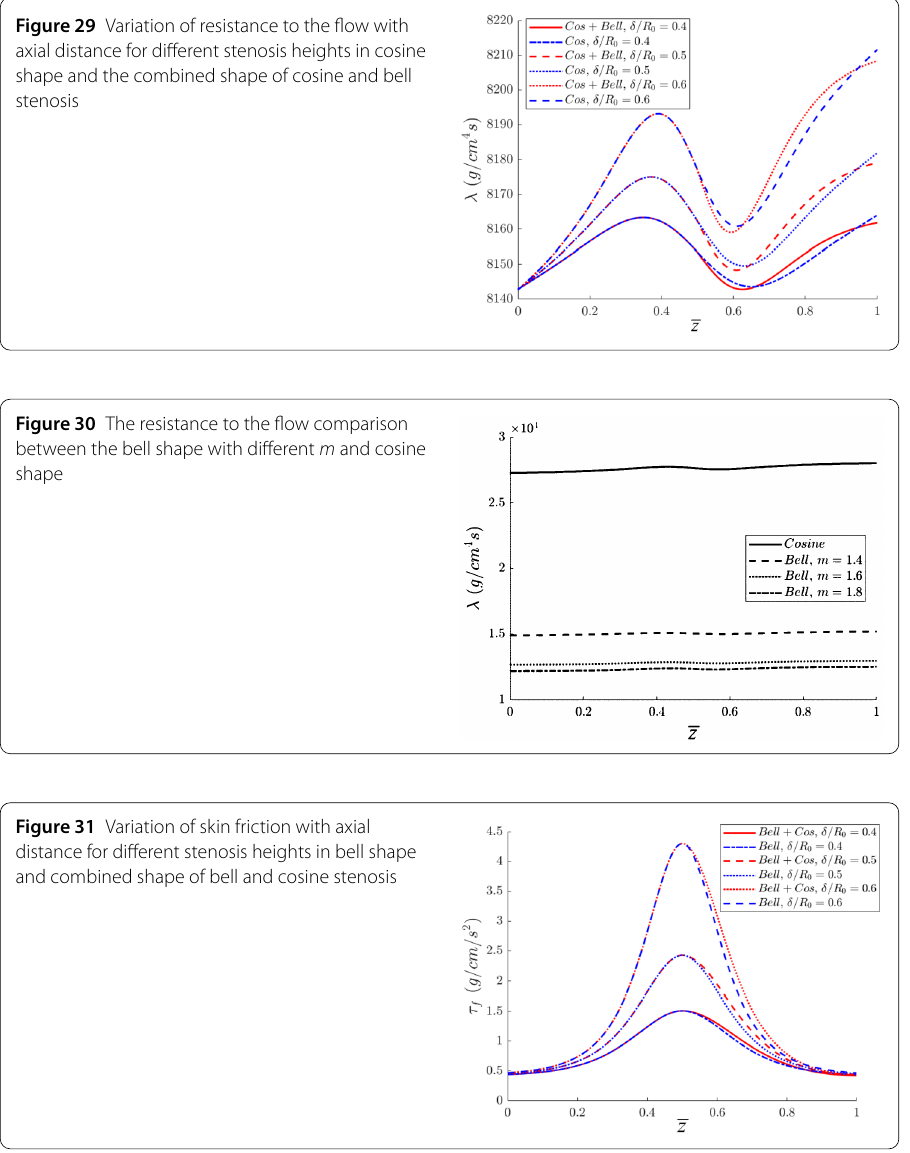
Axial velocity is the highest at the center of the stenosed artery which corresponds to the results of P.K. Mandal, M. M. Molla, and S. P. Shupti. Radial velocity shows a much lower value than axial velocity which is in accordance with P.K. Mandal also. Axial and radial velocity increase with the increase of stenosed height and stenosed length. The effect of non-Newtonian fluid shows that the velocity in axial and radial directions of Newtonian fluid is higher than the non-Newtonian fluid. Axial velocity and radial velocity in the cosine shape are much lower than in the bell shape. From the entrance of the stenosed region to the center of stenosed region, the single shape (bell shape or cosine shape) and combined shape display the same value of axial and radial velocity. However, from the center to the exit of the stenosed region, axial velocity in the single shape is slightly different from the combined